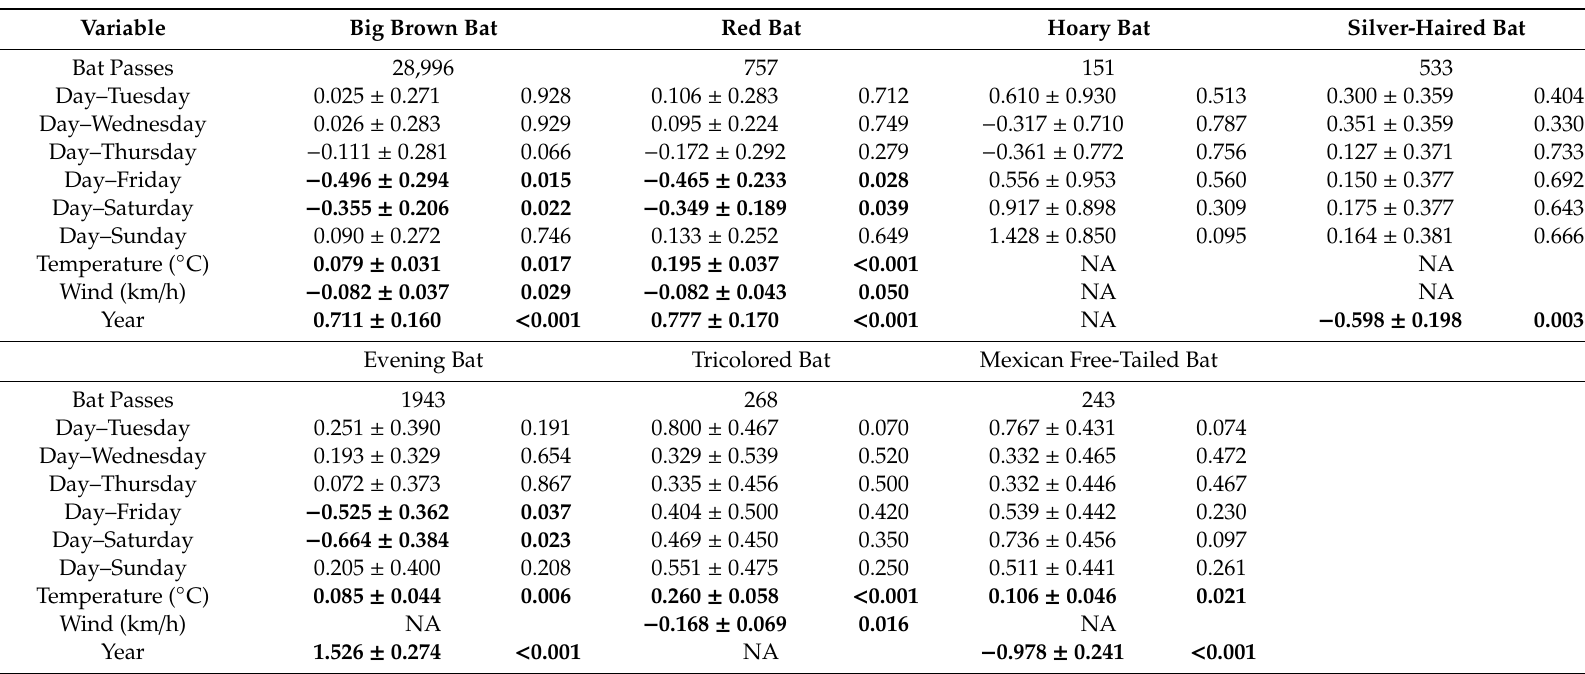
Table 4. Numbers of species-specific bat passes collected in 2018 and 2019 summers and generalized linear model results (species-specific bat passes versus day of the week and environmental covariates, regression estimate ± standard error and p value reported) at the University of North Carolina Greensboro open site in Greensboro, North Carolina, USA. “NA” indicates variables dropped from the final model. Bold numbers indicate significant